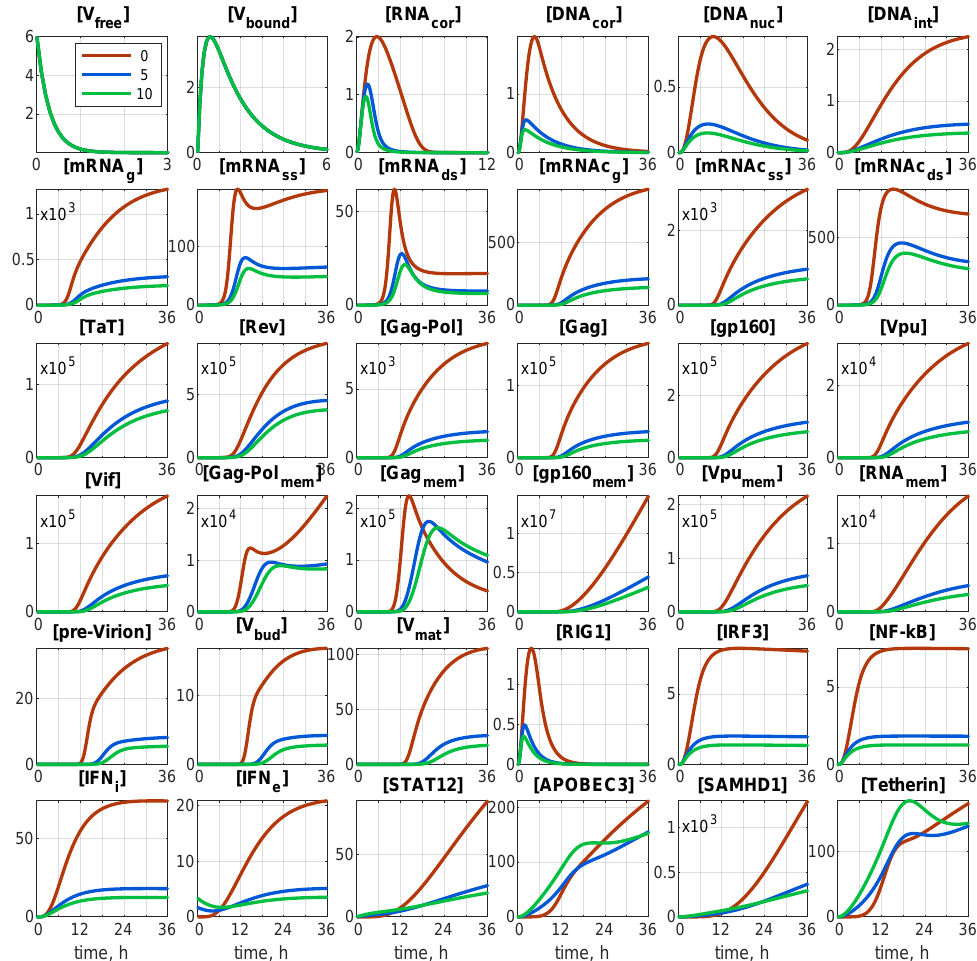
Figure 2. Deterministic trajectories for all components for MOI = 6 and for different values of initial interferon [ IFN e ]( 0 ) . Red line: 0 molecules; blue line: 5 molecules; green line: 10 molecules. Note that all components are indicated through the number of